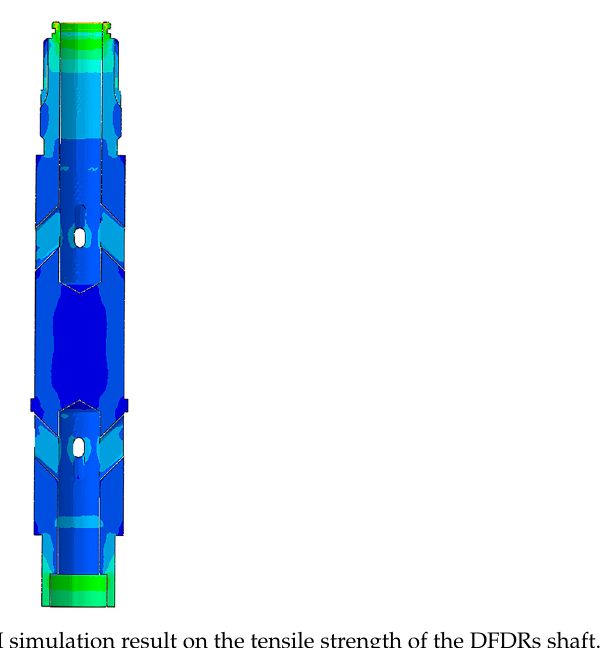
Figure 6. FEM simulation result on the tensile strength of the DFDRs shaft.